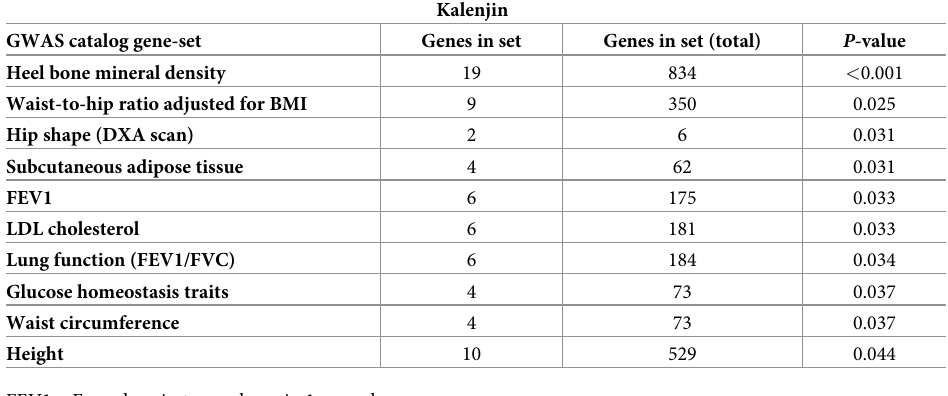
Table 1. Enriched gene-sets, in Kalenjin, for “endurance relevant” traits in GWAS Catalog ( P < 0.05 after FDR correction). The number of genes in Kalenjin’s list is shown for each trait (Genes in set). Gene’s names can be found in S2